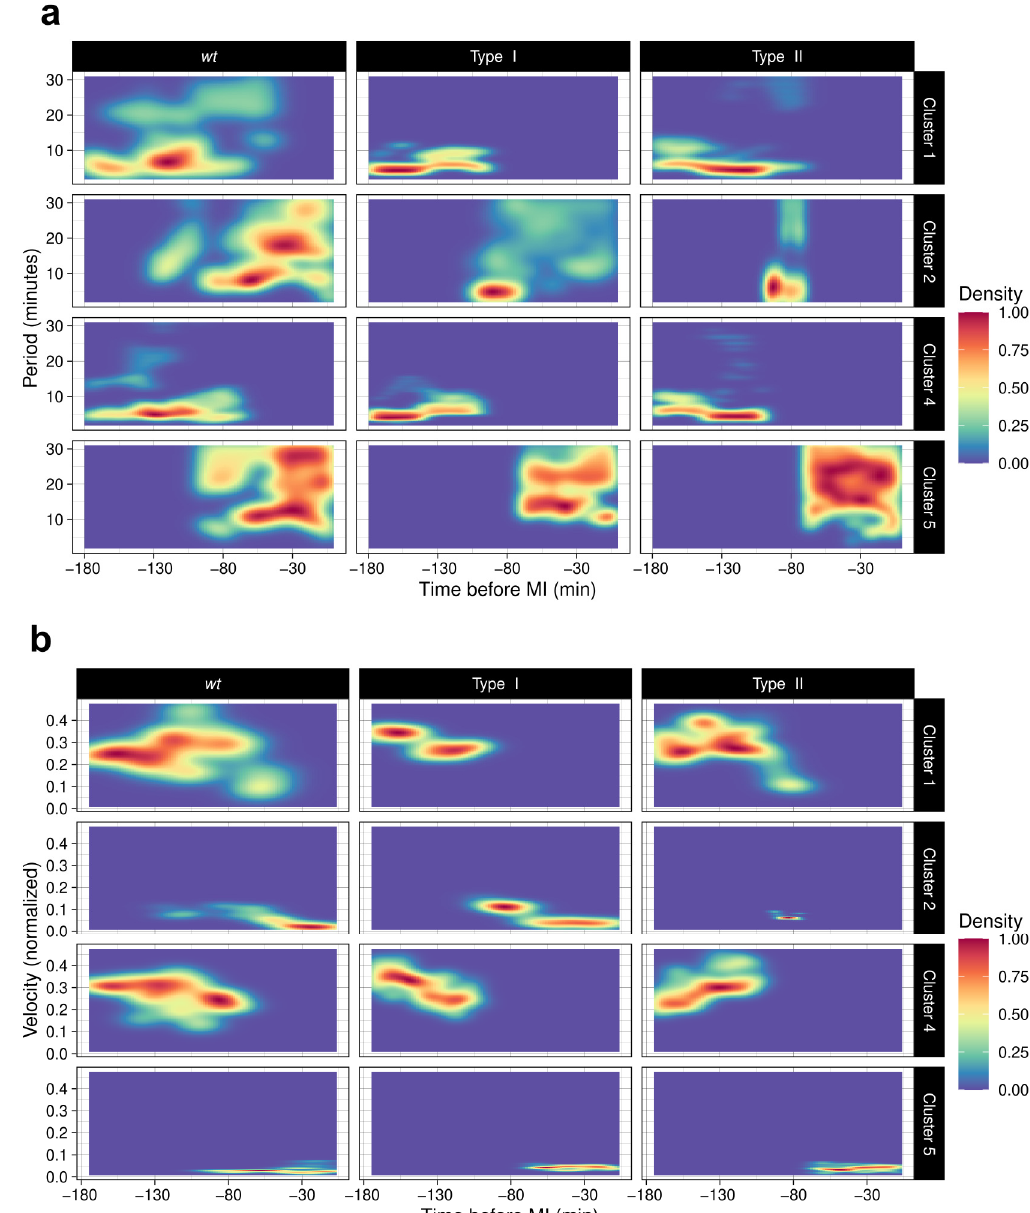
Figure 4. Temporal assessment of spectrum and velocity, per cluster, across wt , Type I and II (synthetic) datasets. Heatmaps, faceted by experimental group and behavioural cluster, for ( a ) data-ensemble spectral densities; XY axes represent Time and Period in minutes, respectively. ( b ) Heatmaps of velocities across the dataset; XY axes represent Time and Velocity, in minutes and normalized as AU/minute. Colour level represents the normalized density for period or velocity.